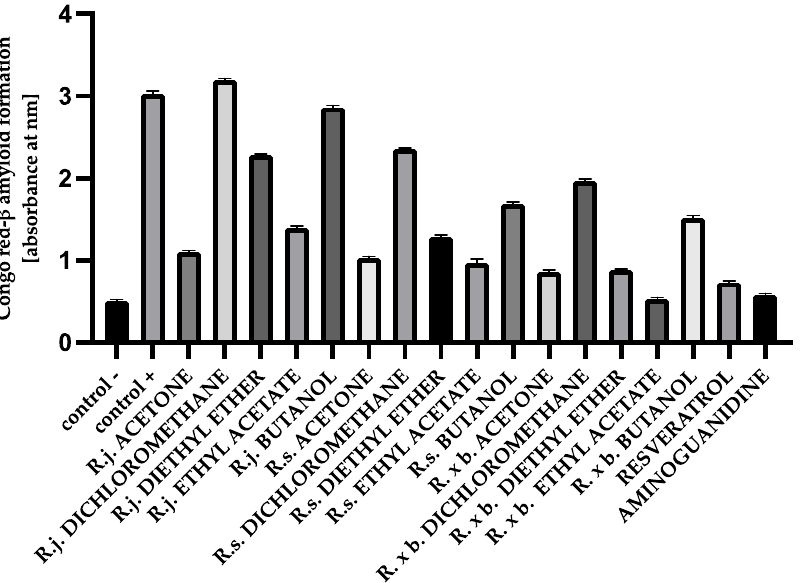
Figure 12. The effect of extracts and fractions on the in vitro formation of amyloid- β products—Congo red in BSA glycation. R.j., R.s., and R. × b. mean Reynoutria japonica , Reynoutria sachalinensis , and Reynoutria × bohemica , respectively. Error bars shown in this figure are means ± SD for n ≥ 5. All results were statistically significant at p ≤ 0.0001 compared to control +. Detailed information can be found in the Supplementary Material. For HSA, the presence of most extracts and their fractions effectively inhibited amy- loid- β aggregation by 89–61%. The results for HSA are shown in Figure 13.